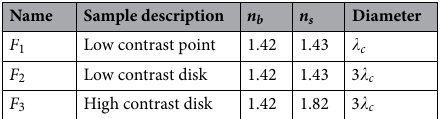
Table 2. Properties of each of the three samples investigated.